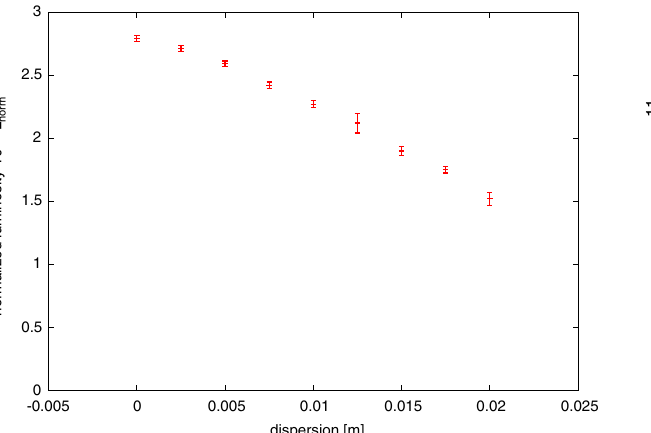
FIG. 7. (Color) Maximum normalized luminosity obtained dur- ing tune scans as a function of the spurious dispersion D x ¼ D y at the electron lens.